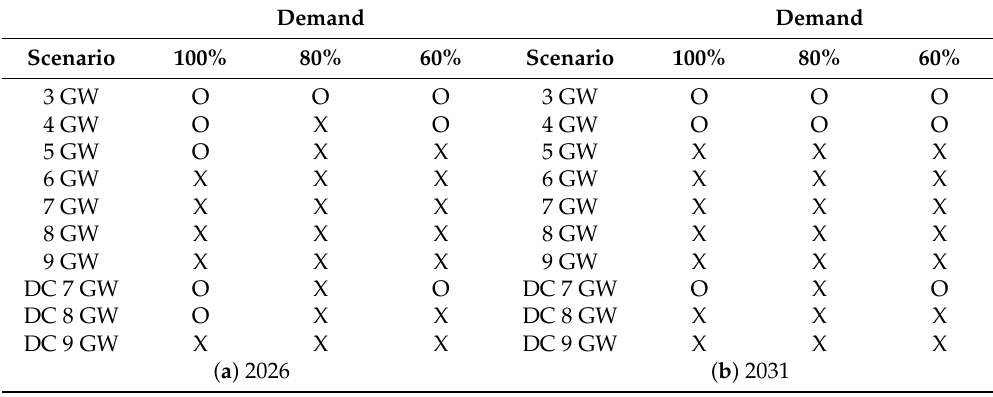
Table 13. Result of the LVRT analysis for a bus connected to renewable energy. Demand